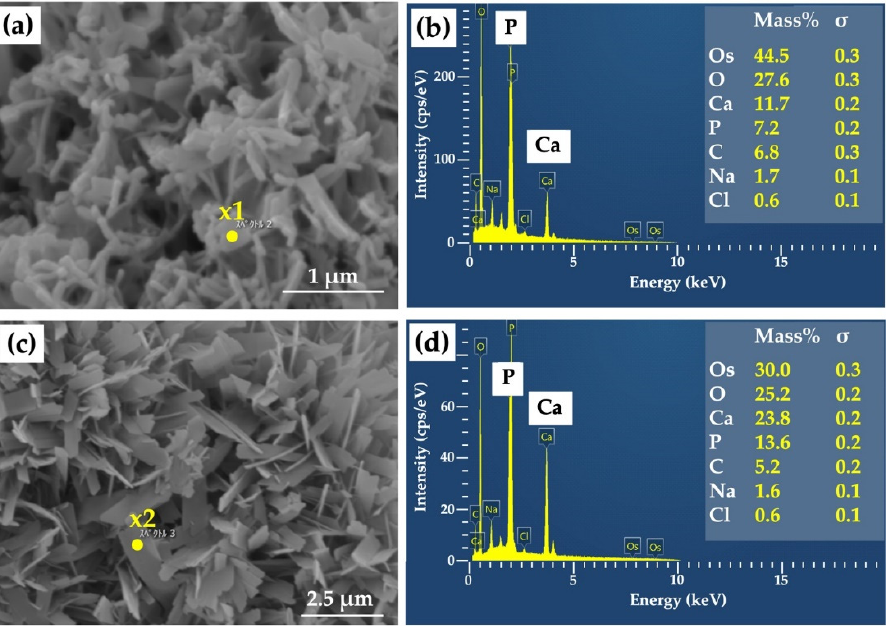
Figure 4. ( a ) High-magnification SEM image of a collagen/apatite composite (AI 20 min 5Cy Col/Hap); ( b ) EDS spectrum and compositional analyses of “x1” in Figure 4a; ( c ) high-magnification SEM image of another collagen/apatite composite (AI 60 min 5Cy Col/Hap); ( d ) EDS spectrum and compositional analyses of “x2” in Figure 4c. Note: ( a , c ) 10,000× magnification.